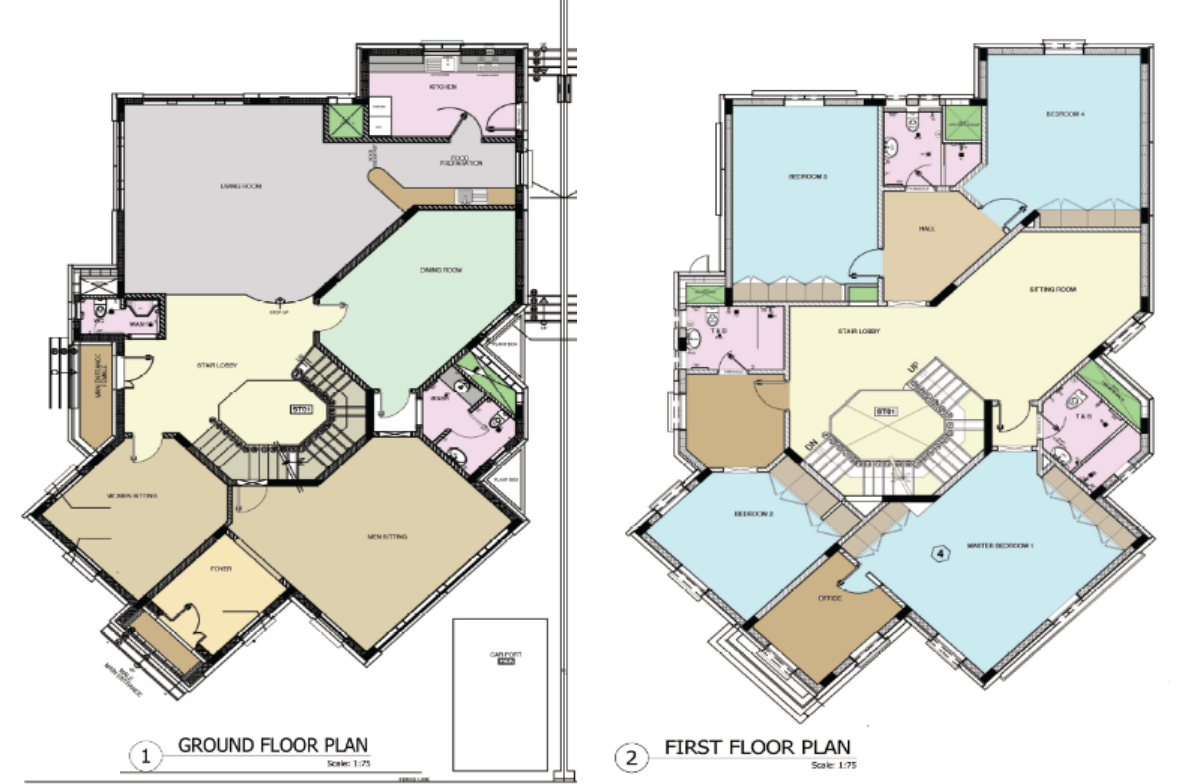
Figure 5. Ground and first-floor plans for villa